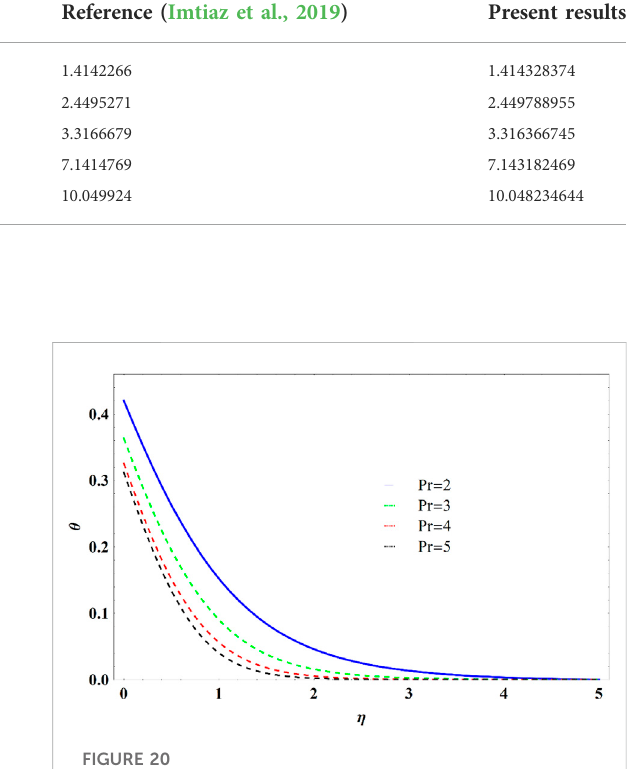
FIGURE 20 Disparity of Pr on θ